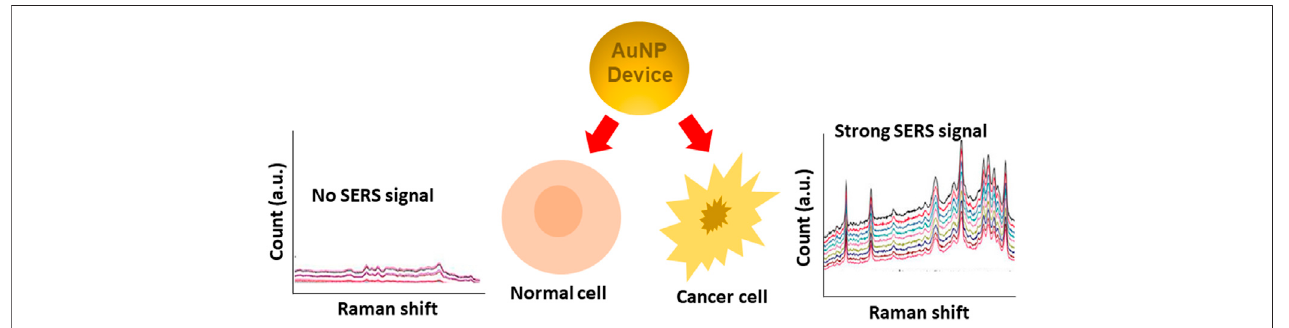
FIGURE 8 | AuNP based SERS for metastatic cancers